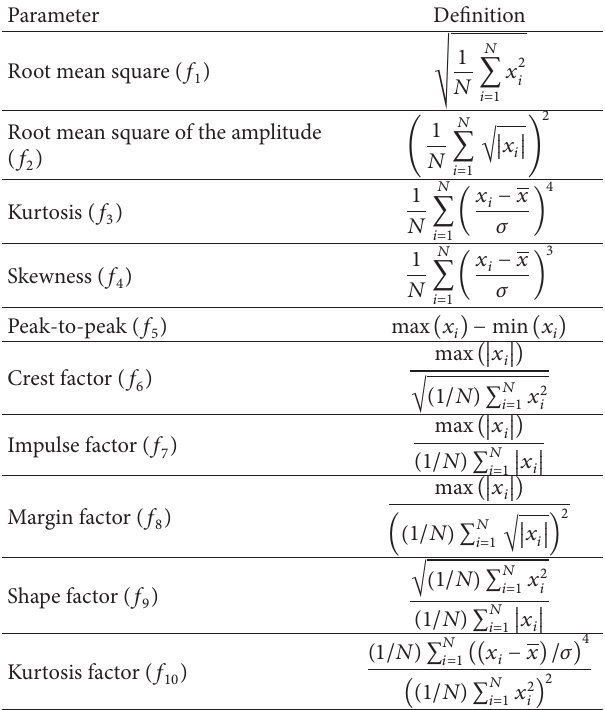
Table 1: Time domain statistical feature parameters.